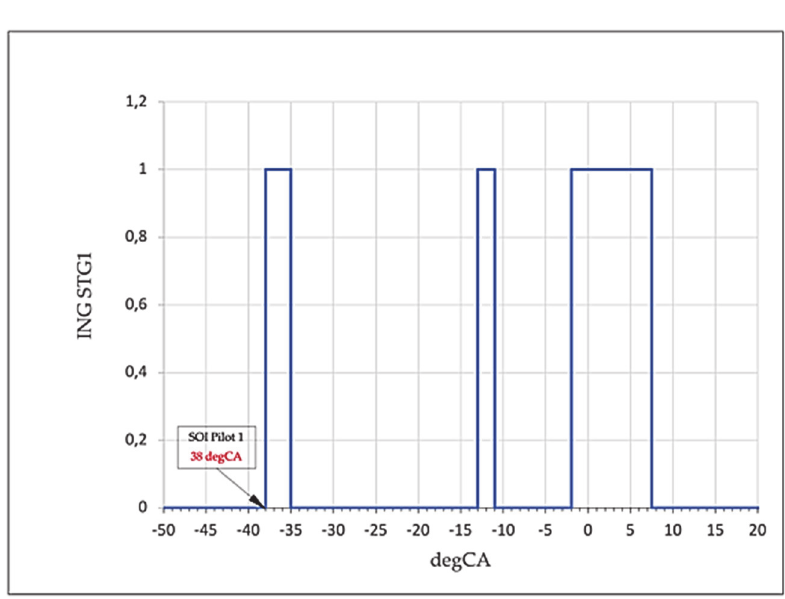
Figure 6. Injection control series.